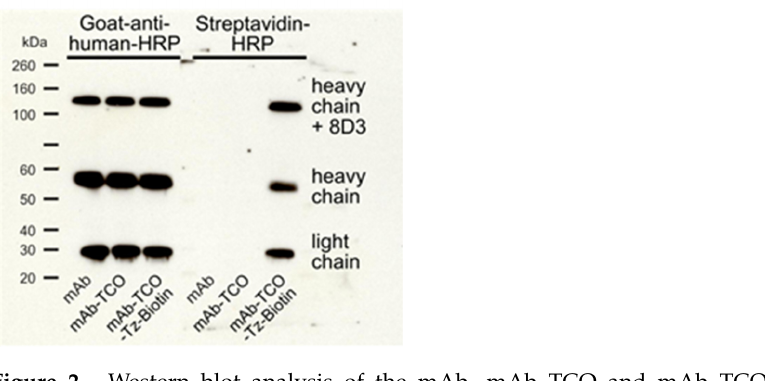
Figure 1. Nomenclature of compounds used in this study. Conjugation of NHS–TCO to mAb and the IEDDA cycloaddition between the modified antibody mAb–TCO and a [ 3 H]-labeled tetrazine derivative Tz to form mAb–TCO–Tz.